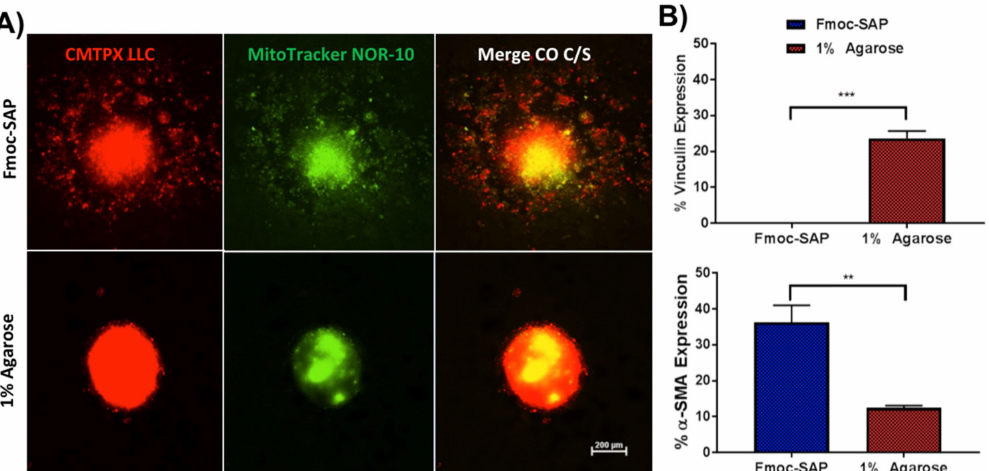
Figure 4. Tracking co-culture lung cancer spheroid migration in functionalised Fmoc-SAP and unfunc- tionalised 1% agarose hydrogels. ( A ) Migration of co-culture 3D spheroids tracked by labelling